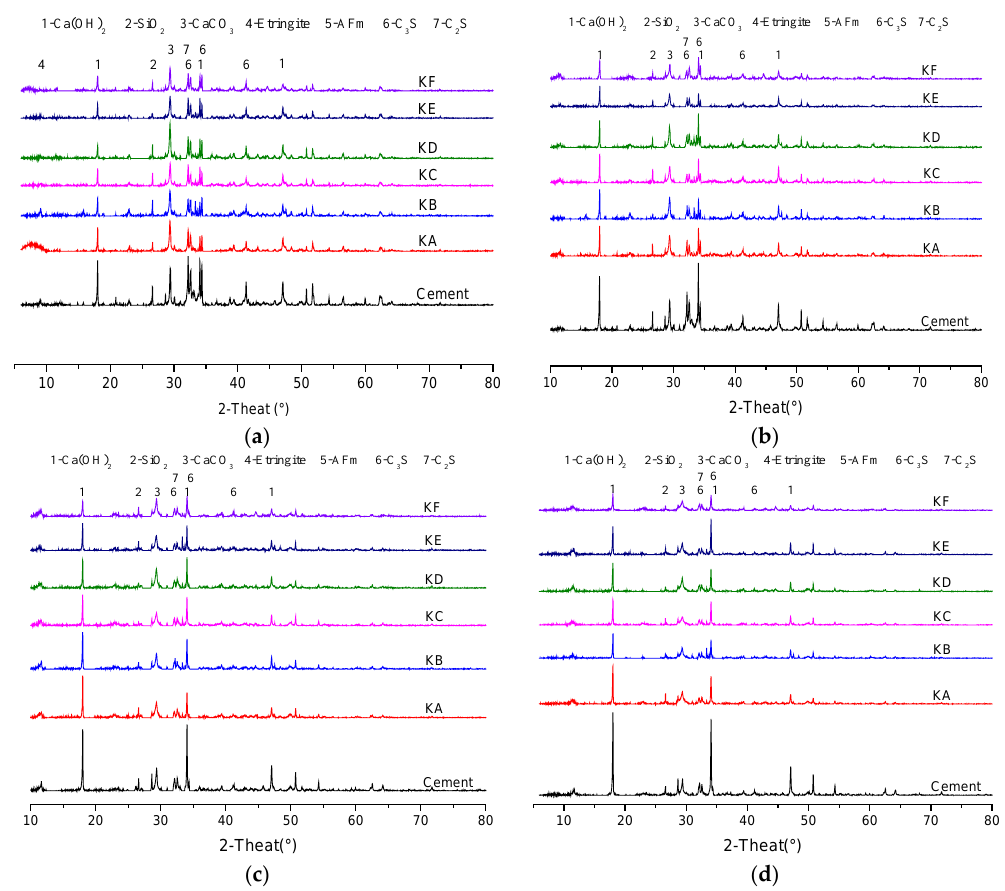
Figure 5. XRD patterns of specimens with different SSA . ( a ) XRD patterns of specimens at 1 day; ( b ) XRD patterns of specimens at 3 days; ( c ) XRD patterns of specimens at 7 days; ( d ) XRD patterns of specimens at 28 days.